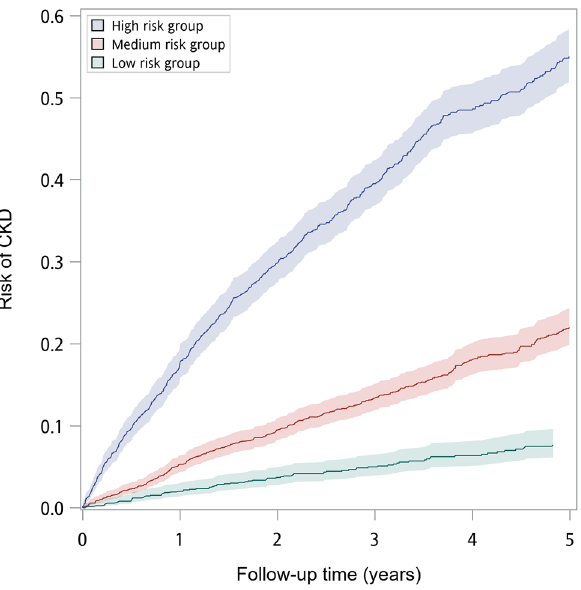
Figure 2. The 5-year cumulative incidence of low, median, and high groups from validation set.